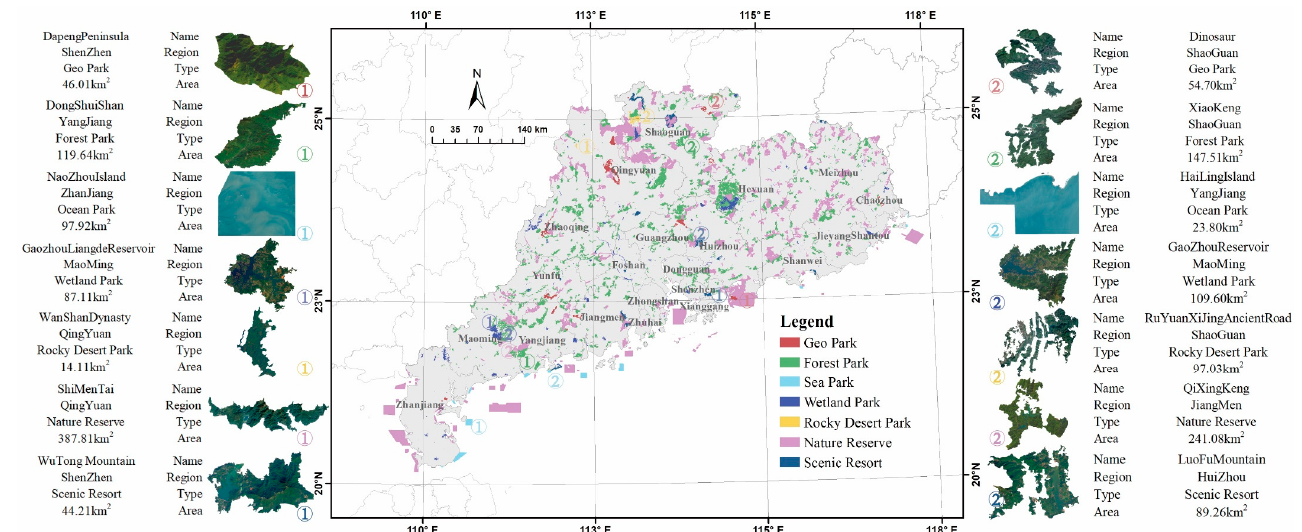
Figure 1. The spatial distribution of the PAs in Guangdong. Figure.1 The spatial distribution of the PAs in Guangdong.